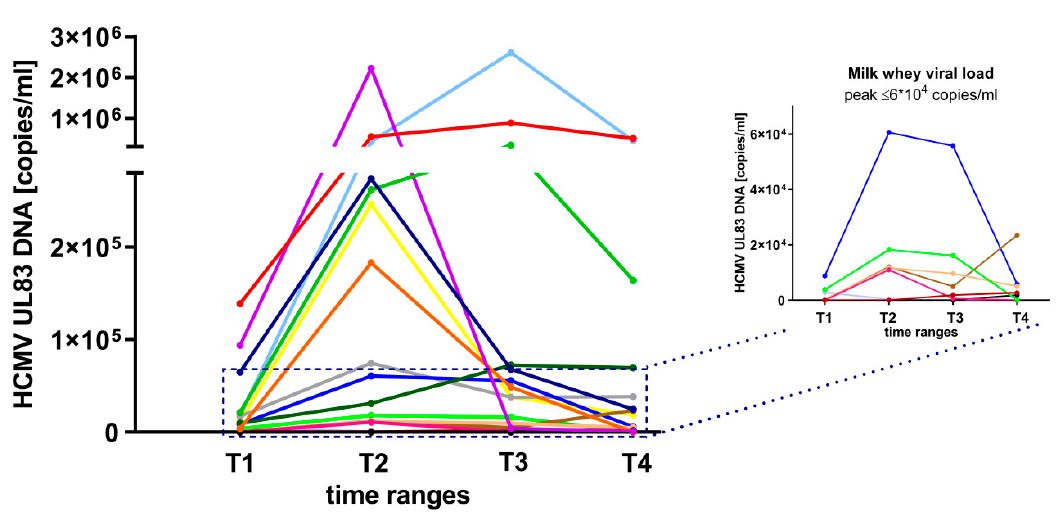
Figure 1. Milk whey viral loads (target region UL83) of 17 of 18 HCMV-seropositive BlooMil study mothers at T1 (10 to 15 days pp), T2 (25 to 30 days pp), T3 (40 to 45 days pp) and T4 (55 to 60 days pp). The insert shows low viral loads (peak levels ≤ 6x10 4 copies / mL). One mother did not reactivate during observation. Individual color identification.